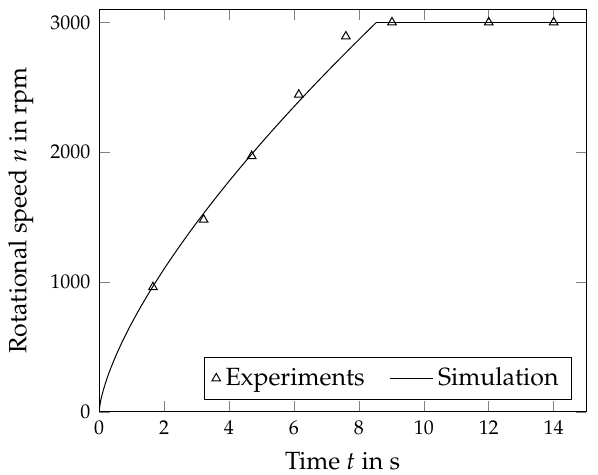
Figure 5. Start-up process of the